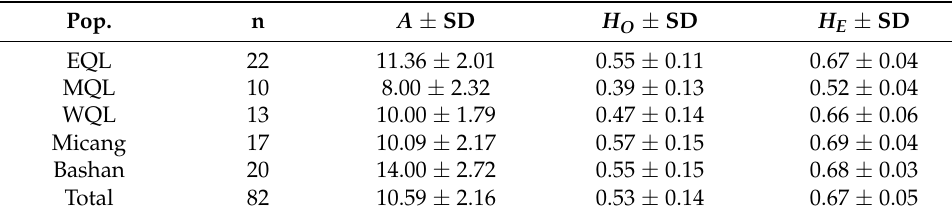
Table 3. Genetic diversity from 6 gene pools by using 12 microsatellite loci.